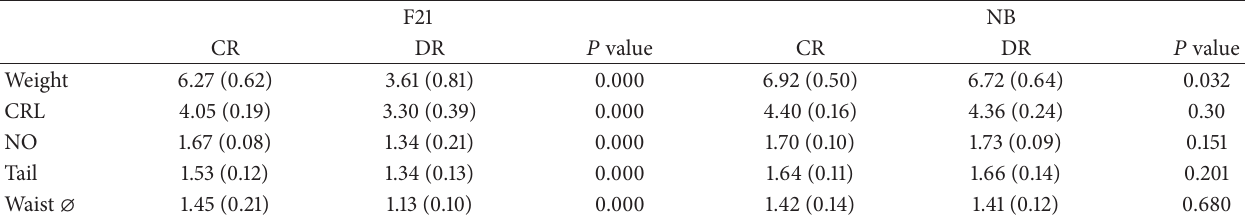
Table 4: Maternal hyperglycemia effect on pup somatometry of control rats (CR) and diabetic rats